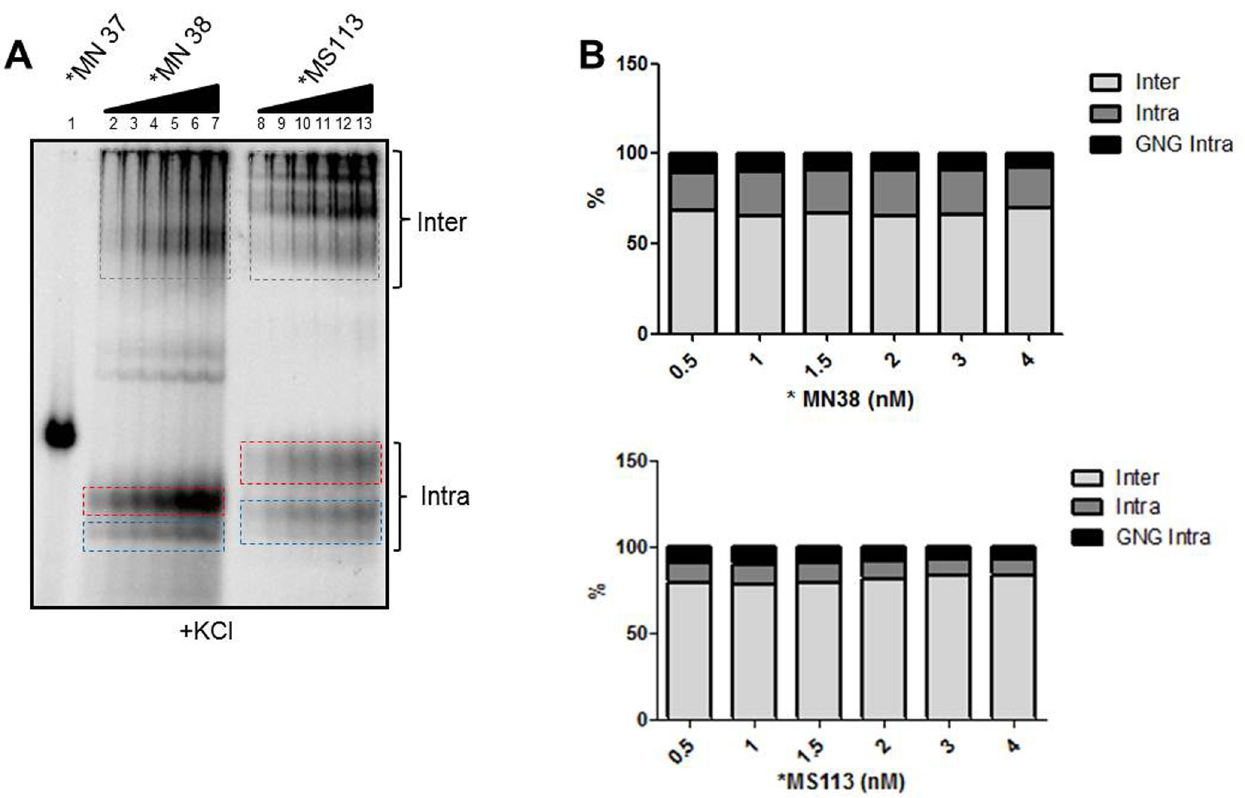
Fig 2. Impact of increase in concentration of oligomers on formation of inter and intramolecular G-quadruplex species. The wild type DNA sequence spanning region I of HOX11 breakpoint region, MN38 (G-rich strand) or MS113 (mutant) was used for titration. MN37, the C-rich strand was used as a negative control. (A) EMSA gel shows formation of inter (boxed grey) and intramolecular G-quadruplexes. The intramolecular G-quadruplexes were further divided into species with (boxed blue) or without (boxed red) GNG motifs. (B) Bar diagram shows quantification of inter and intramolecular species over a range of oligonucleotide